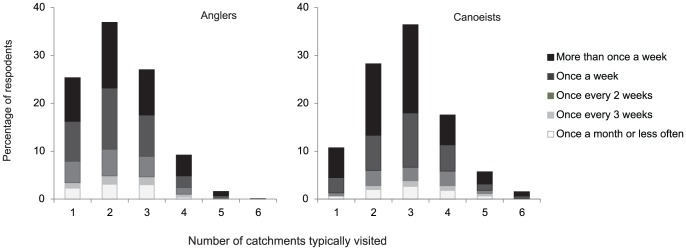
Typical number of UK catchments visited by canoeists and anglers.Shading shows the frequency with which respondents travelled between the catchments that they visited.